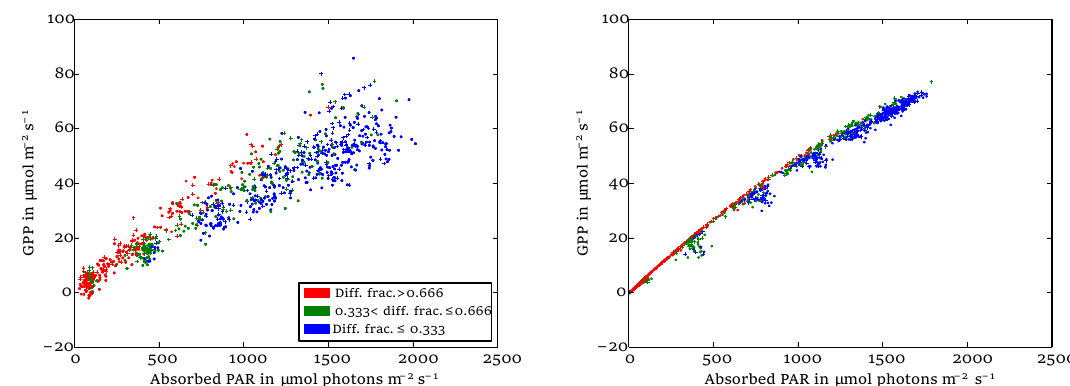
Figure 19. GPP (in µmolCO 2 ( m 2 ground ) − 1 s − 1 ) against absorbed PAR (in µmolphotons (m 2 ground) − 1 s − 1 ) for the hourly FLUXNET data (left) and hourly output from the model runs (right). LAI is between 3.5 and 4.5 and all points have DVI less than 1. Dots and vertical crosses (+) indicate US-Ne1 and US-Ne2 respectively. Colour: diffuse radiation fraction. JULES runs have the crop model switched off, LAI and canopy height prescribed and the input parameters in Tables 1, 2, and 4.